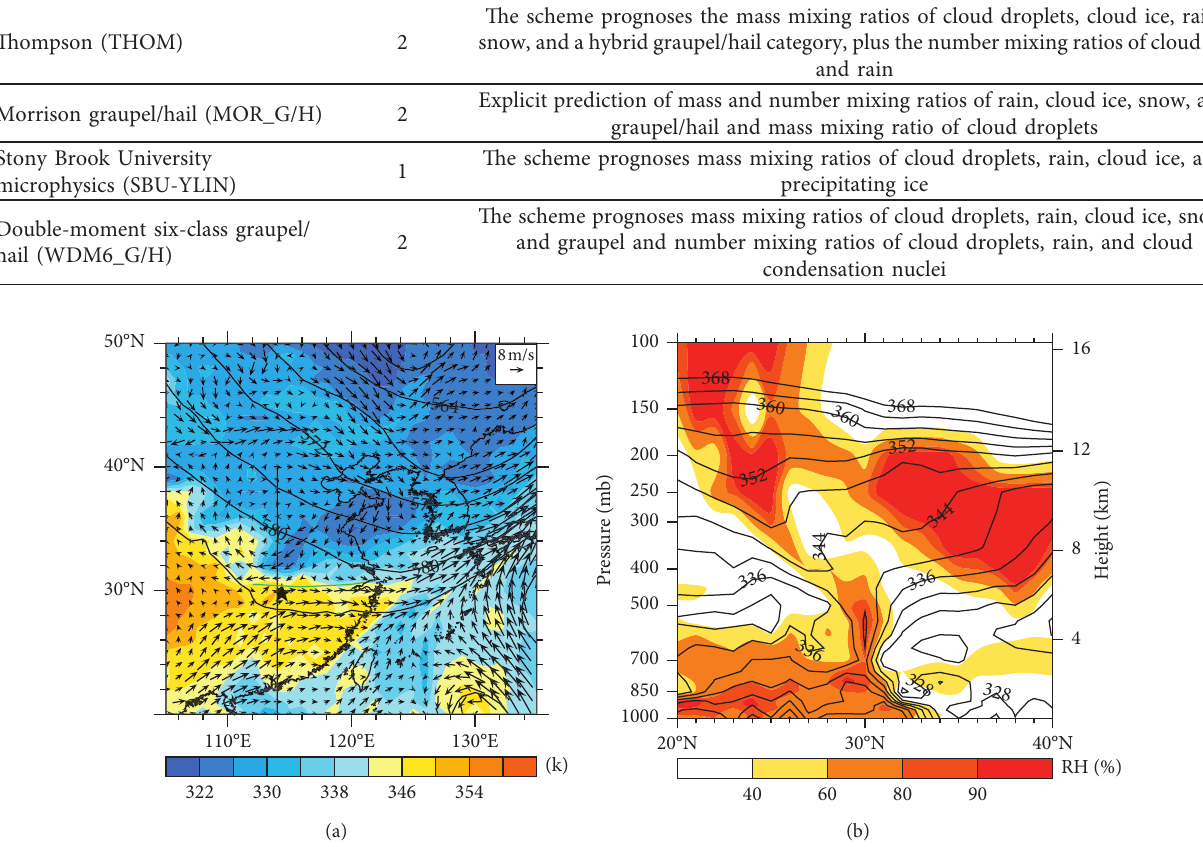
Figure 2: Large-scale air flow and thermodynamic conditions at 0000 UTC 30 June 2018 from ERA-5 reanalysis.(a) Horizontal wind vector (arrows) at 700hPa, geopotential height at 500 hPa (thick solid lines), and pseudo-equivalent potential temperature at 850hPa (shading). The green line in (a) indicates the winds shear line at 700hPa. (b) Vertical cross sections along 114 ° E of pseudo-equivalent potential temperature (solid lines) and relative humidity